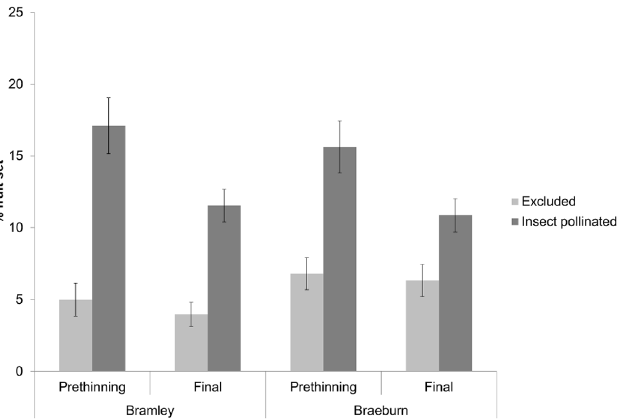
Fig 3. Percentage fruit set pre and post apple thinning for Bramley and Braeburn apples following pollinator exclusion treatments (Mean ± SE).